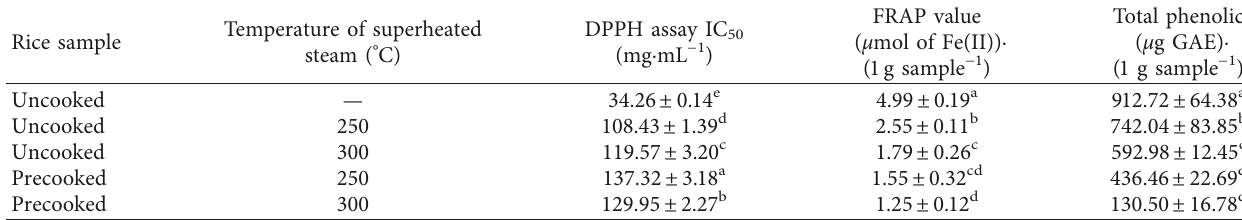
Table 4: Antioxidant activity of black glutinous rice with/without superheated steam treatment. Rice